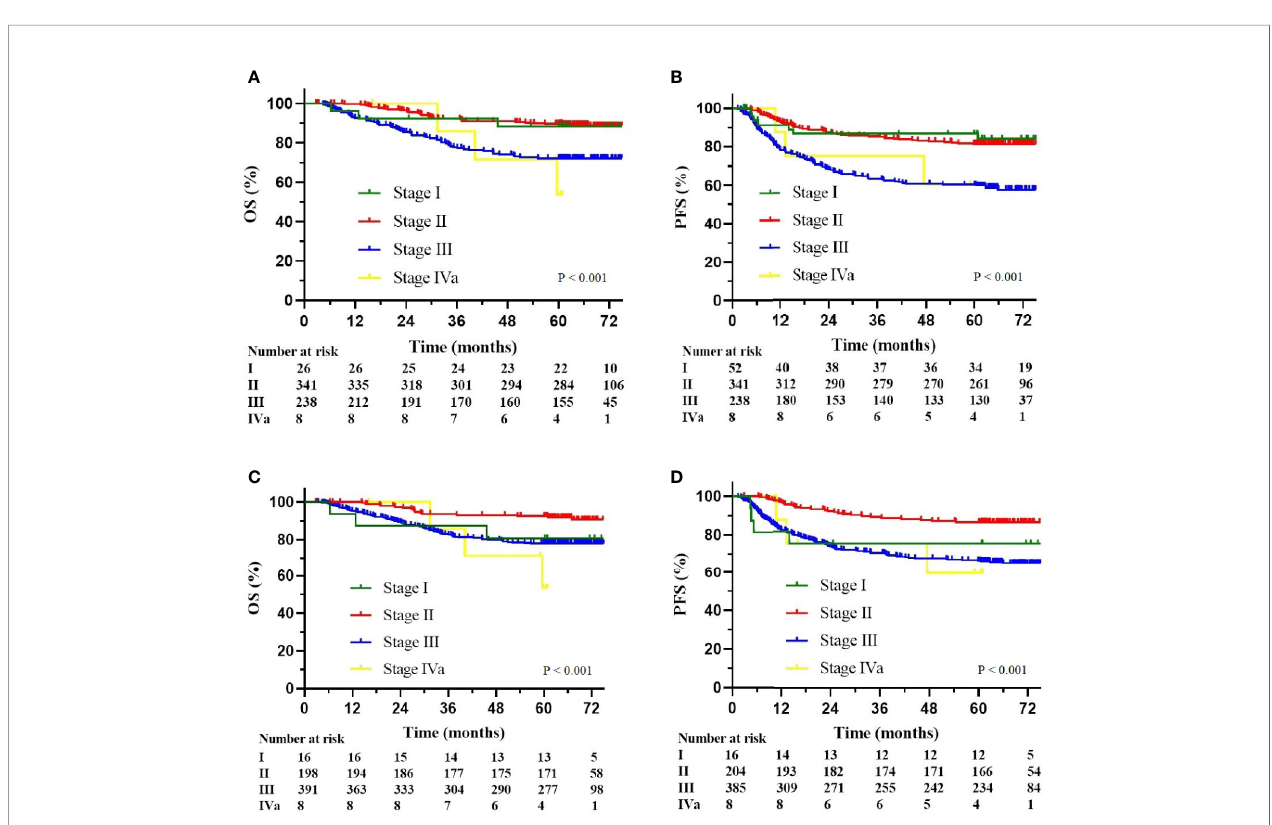
FIGURE 4 | Overall survival and progression-free survival strati fi ed by nomogram score. (A) Kaplan-Meier overall survival curves. (B) Kaplan-Meier progression-free survival curves. The groups are divided by nomogram score (Group 1: less than 50; Group 2: 50 – 100; Group 3: 100 – 150; Group 4: 150 – 200; Group 5: